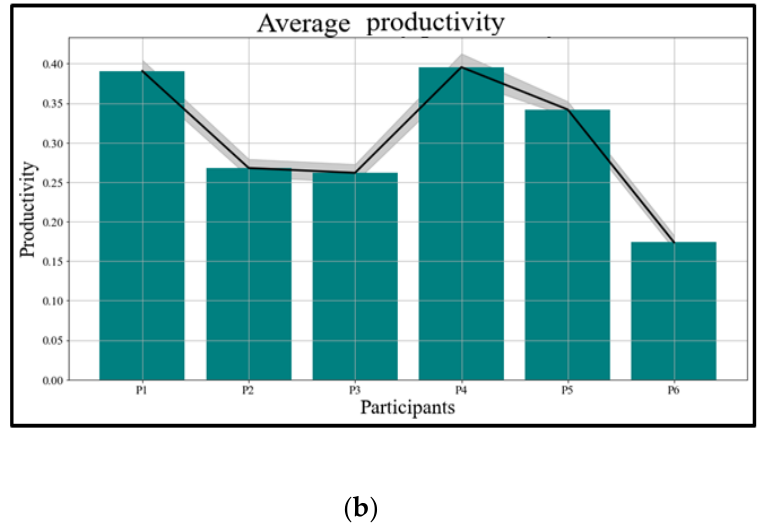
Figure 19. ( a ) Sampled productivities at 4 h frequency. ( b ) participants’ productivity summary.